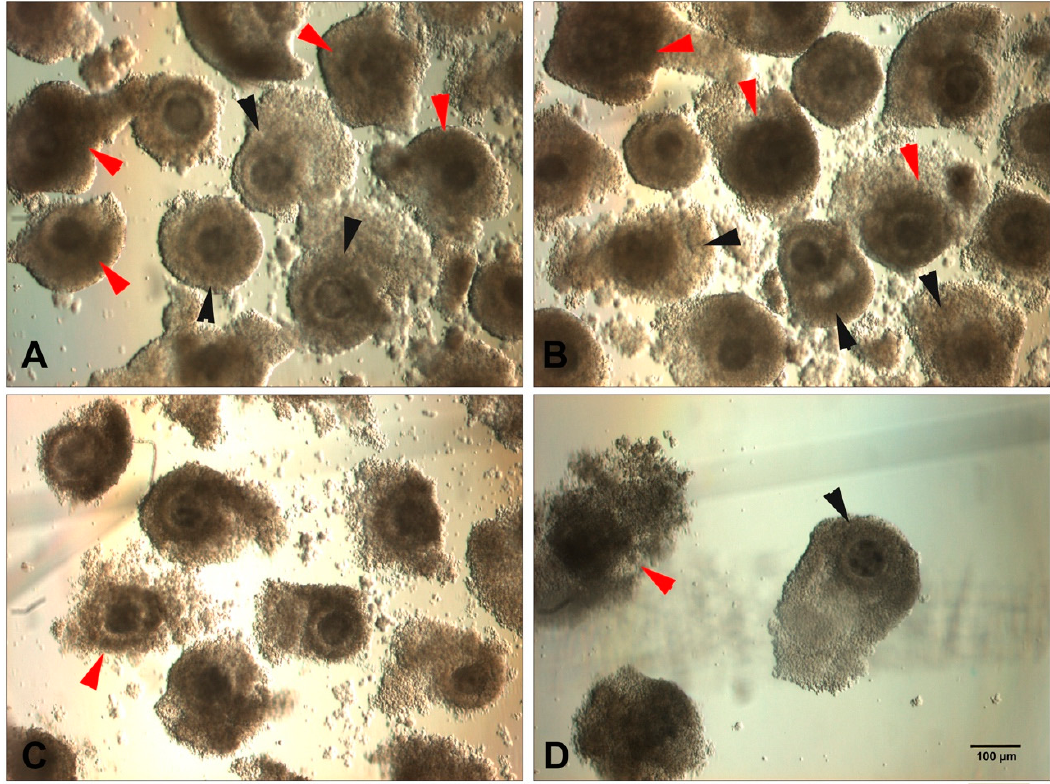
Figure 1. Representative images of bovine cumulus–oocyte complexes (COCs) after ovary withdrawal classified according to COC morphology. ( A , B ) Complete cumulus cover with several compacts (red arrows) and slightly loose (black arrows) cell layers; ( C ) partial cumulus cover and loose cell layers with signs of early atresia (red arrow); ( D ) COC showing clear signs of atresia (red arrow) and a black-punctate cytoplasm (black arrow).